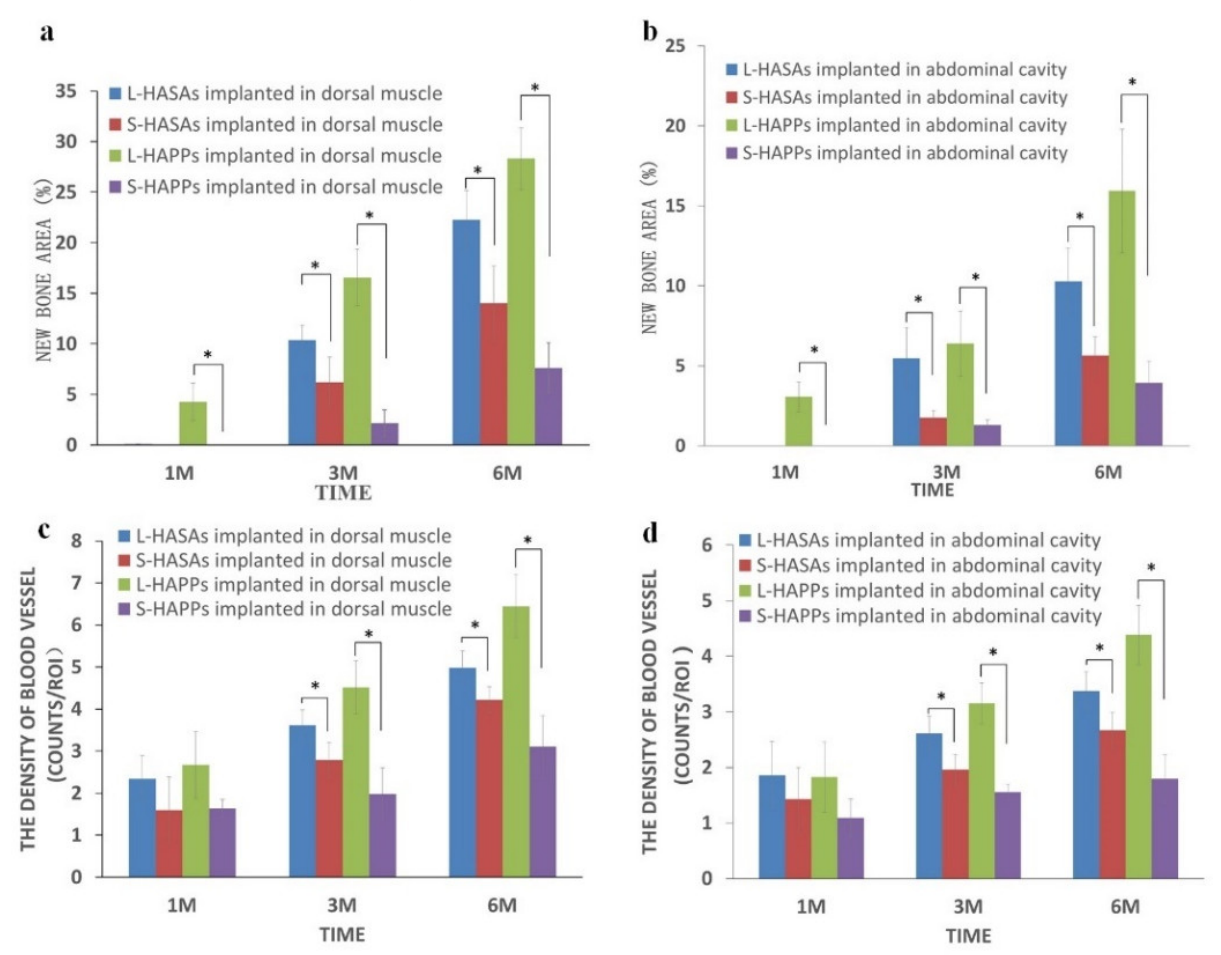
Figure 4. New bone formation and vessel density in HA porous scaffolds with different macropore sizes implanted in dorsal muscle and abdominal cavity using histomorphometry analysis. ( a ): new bone formation area % of HA scaffolds implanted in dorsal muscle; ( b ): new bone formation area % of HA scaffolds implanted in abdominal cavity; ( c ): vessel density of HA scaffolds implanted in dorsal muscle; ( d ): vessel density of HA scaffolds implanted in abdominal cavity (* p < 0.05).